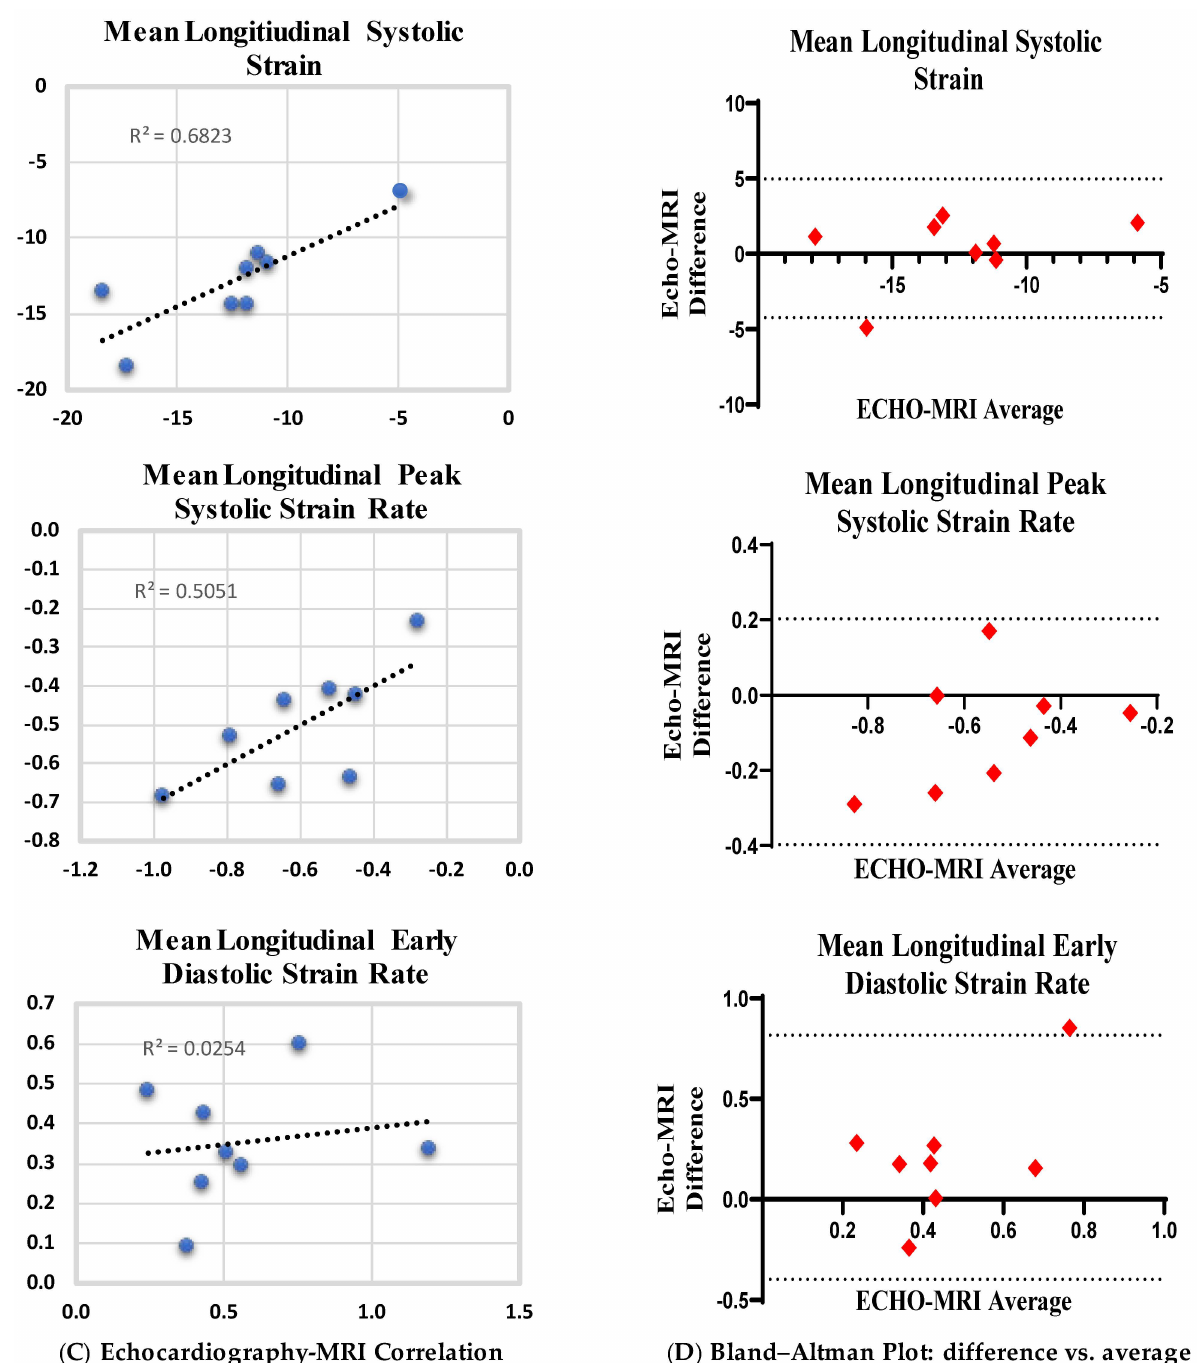
Figure 3. Left ventricular (LV) longitudinal strain imaging of immune checkpoint inhibitor (ICI)-induced cardiomyopathy using cardiac MRI (CMR) under 4 chamber view (4CH). ( A ) Representative 4CH-CMR image of a control; ( B ) Representative 4CH-CMR image of an ICI-treated patient. ( C ) Scatter plots showing the correlation between the mean longitudinal strain and strain rates derived from echocardiography versus CMR. ( D ) Bland–Altman agreement plots for ICI-induced cardiomyopathy detected on echocardiography compared with CMR for mean longitudinal strain and strain rates. Bland–Altman plots display the difference between values measured by echocardio- graphy and CMR against the mean of these 2 values. The upper and lower dashed lines represent the 95% confidence